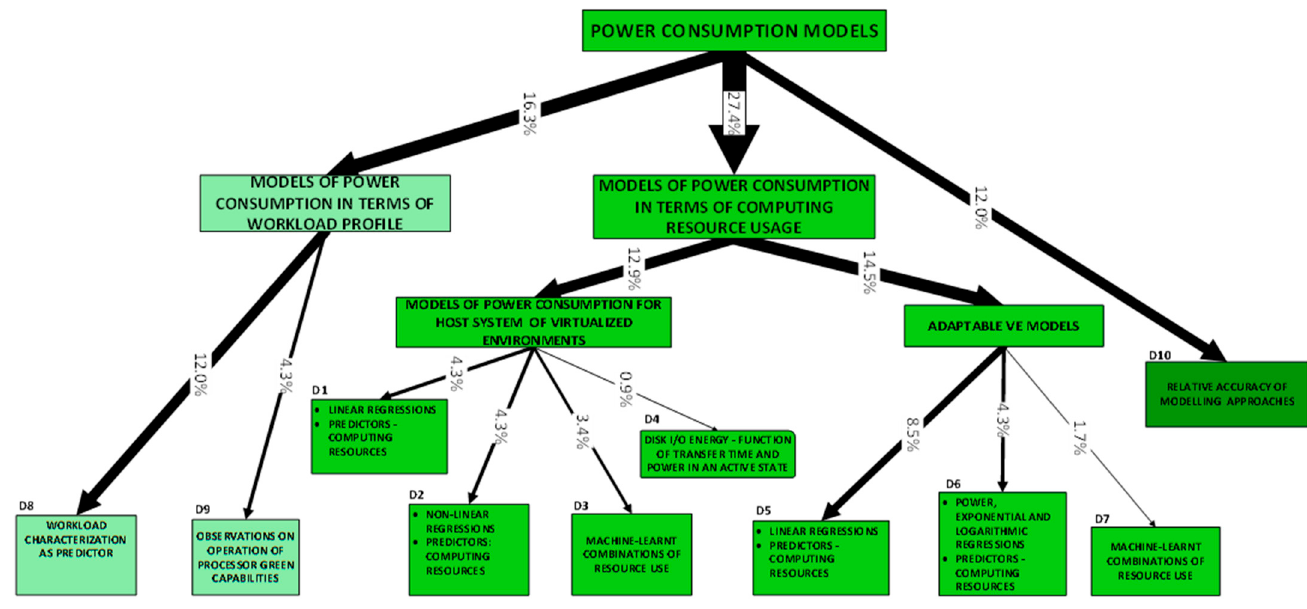
Figure 4. A taxonomy of power models, with frequency of occurrence shown in line thickness and as percentage.